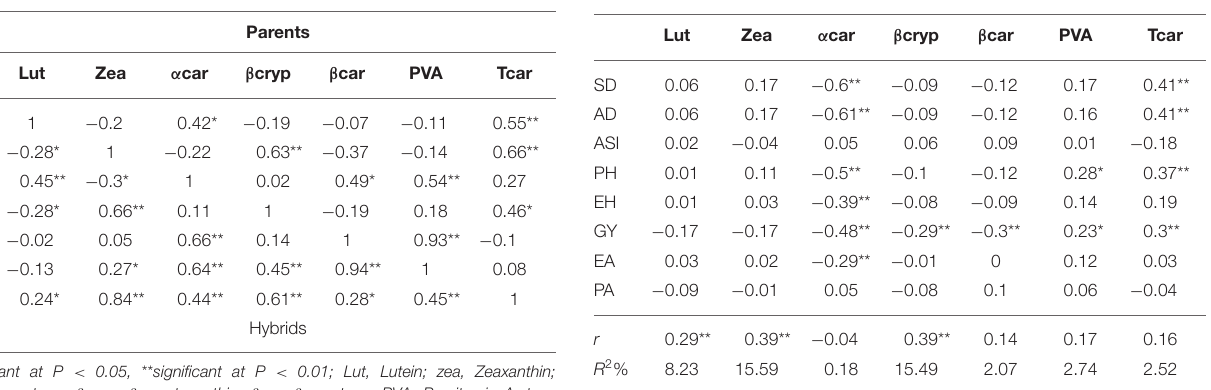
TABLE 7 | Pearson’s coefficient of correlation between carotenoids and agronomic traits averaged across environments and regression of carotenoid content of the F1 hybrids on their mid-parent